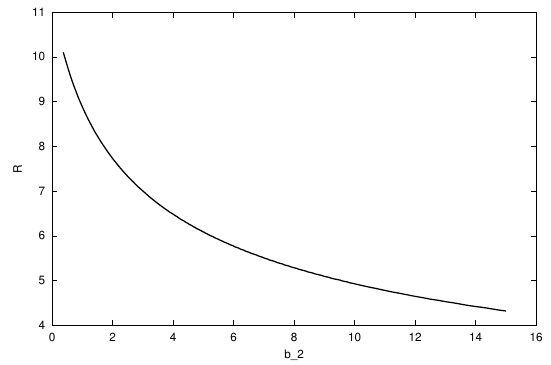
Fig. 7. Distance, as a function of b 2 , to the point where periods of the two shear Alfv·en modes coincide.